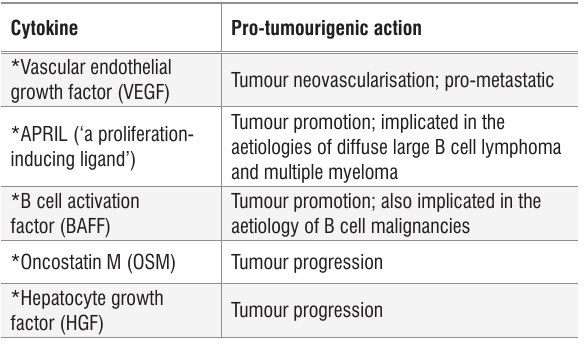
Table 3 : Neutrophil-derived cytokines implicated in tumourigenesis Cytokine